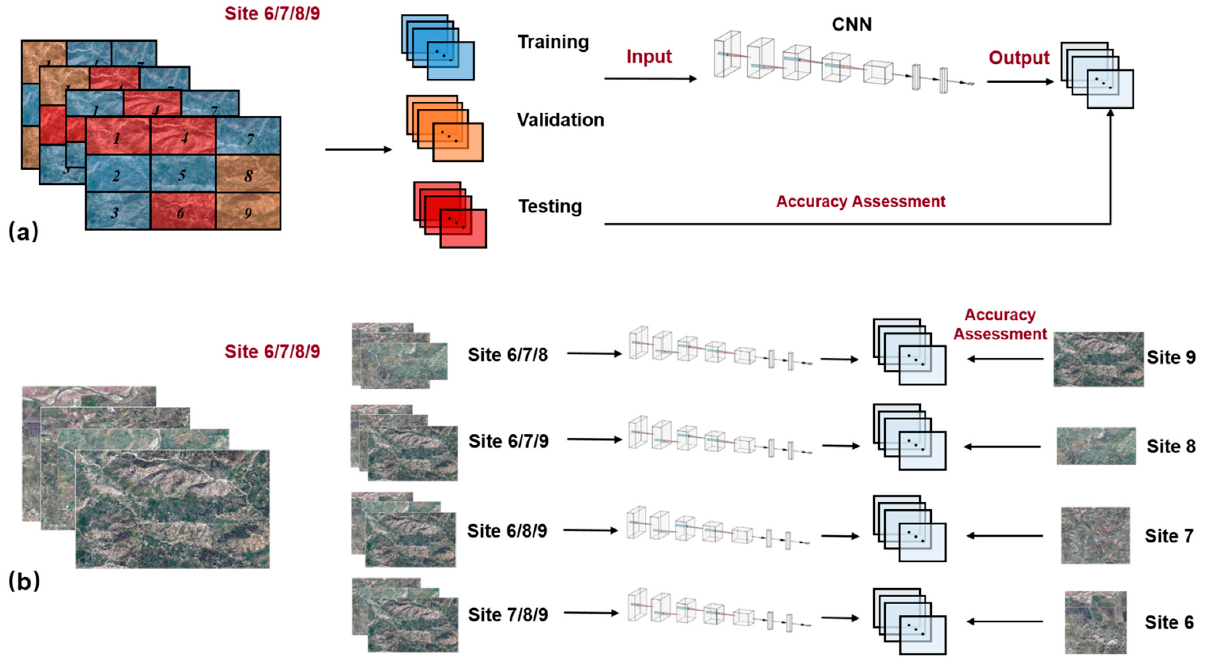
Figure 4. Frameworks of two sampling approaches (see Figure 7 for details of the CNN architecture). ( a ) Grid sampling; ( b ) region sampling.